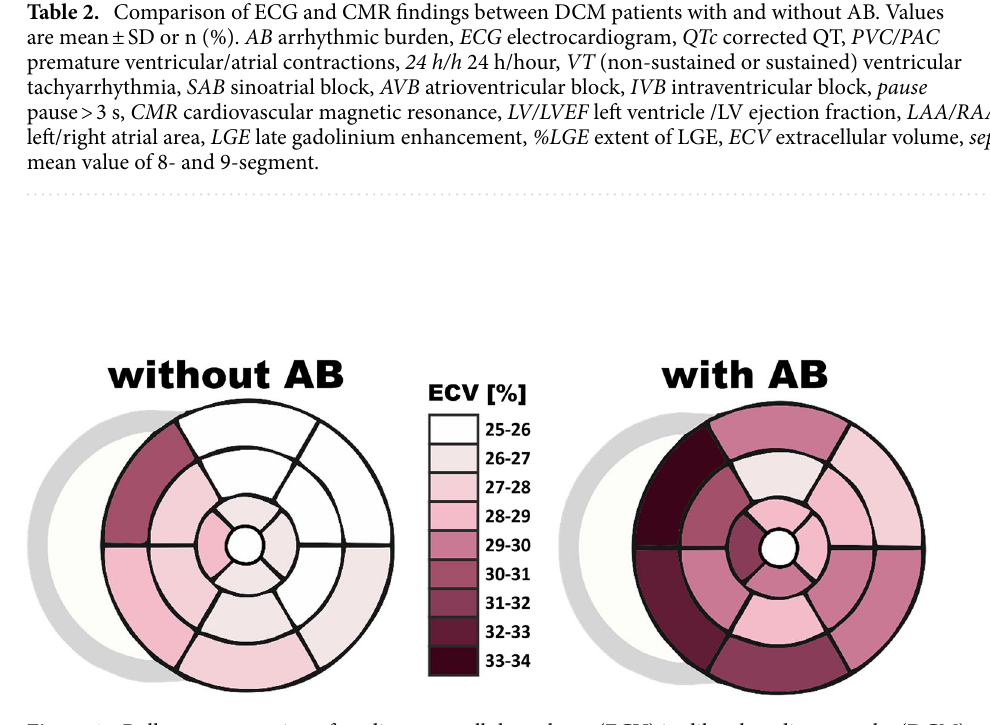
Figure 1. Bull-eye presentation of median extracellular volume (ECV) in dilated cardiomyopathy (DCM) patients with (3A) and without (3B) arrhythmic burden (AB). In both groups, the most fibrotic segments were identified in the